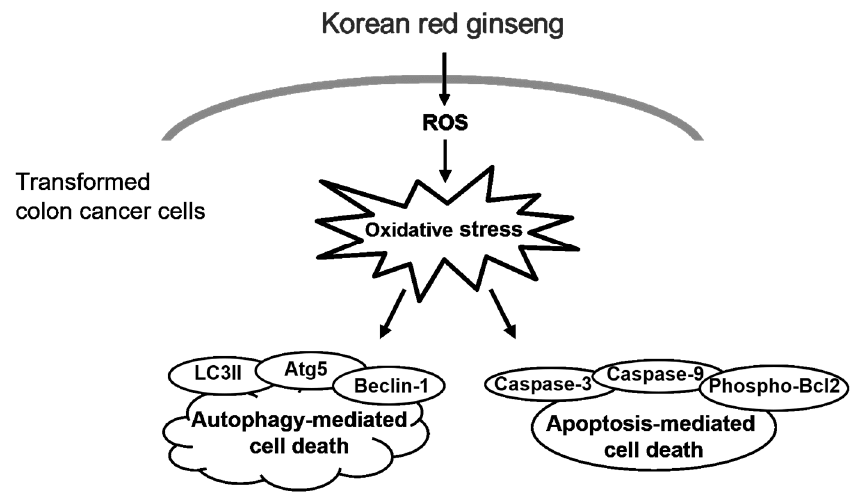
Figure 6. KRG extract induces cell death through oxidative stress. KRG extract-induced ROS generation promotes autophagy- and apoptosis-mediated cell death via activation of phospho-Bcl-2, caspase-3, and caspase-9, as well as Atg5, Beclin-1, and LC3 II.